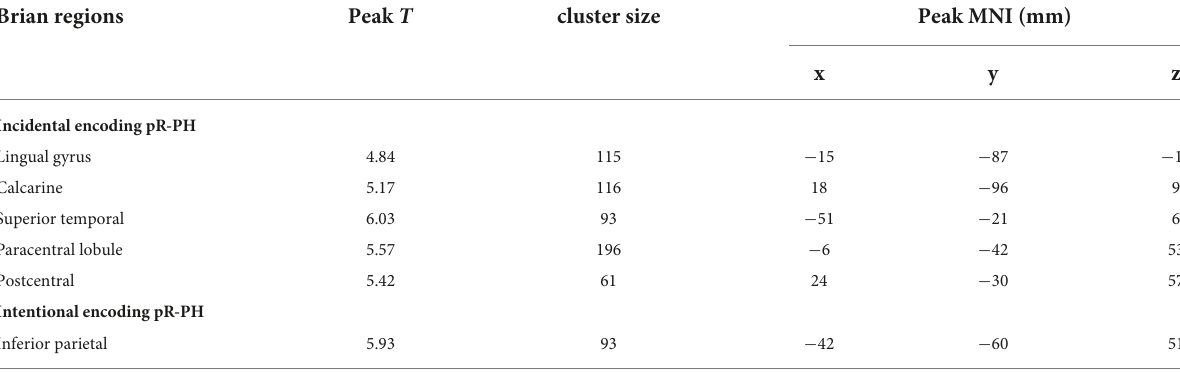
TABLE 3 Correlation between the recollection performance and the rs-FC of the left precuneus and brain regions in healthy controls. Brian regions Peak T cluster size Peak MNI (mm) x y